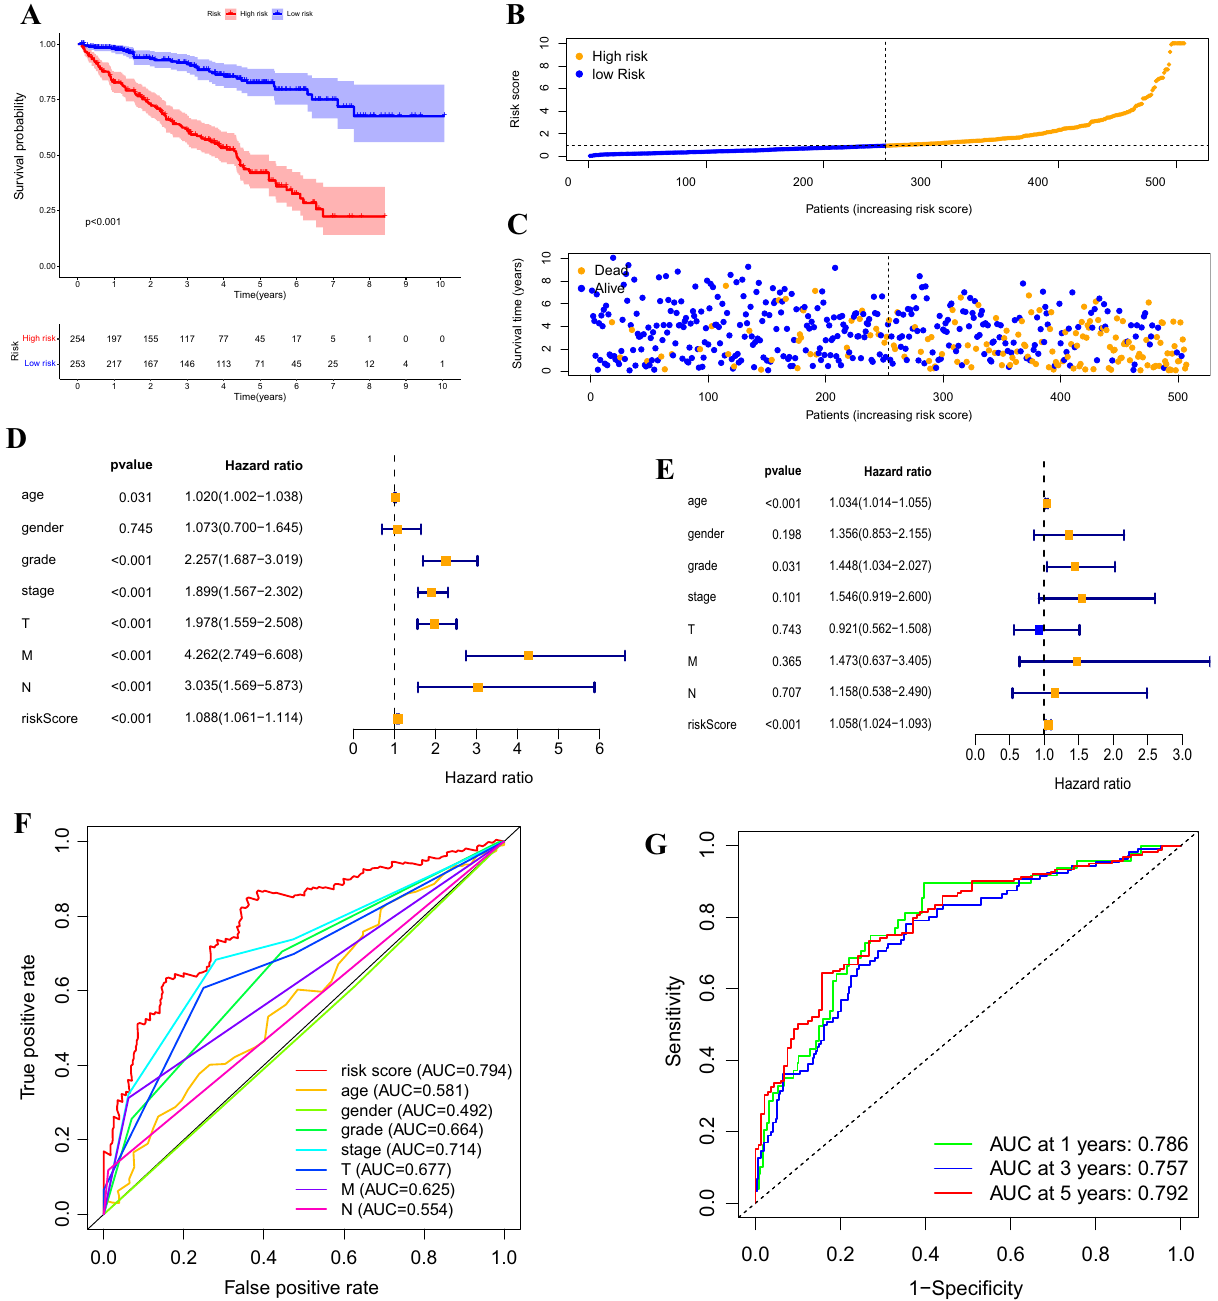
Figure 3. Correlation between the predictive signature and prognosis of patients with ccRCC. ( A ) Kaplan– Meier analysis of the overall survival rate of patients with ccRCC in the high-risk and low-risk groups. ( B ) The distribution of risk score among patients with ccRCC. ( C ) The number of dead and alive patients with different risk scores. Blue and yellow represents the numbers of survivors and deaths, respectively. ( D ) Forest plot for univariate Cox regression analysis. ( E ) Forest plot for multivariate Cox regression analysis. ( F ) The ROC curve of the risk score and clinicopathological variables. ( G ) ROC curve and AUCs at 1, 3, and 5 years survival for the predictive signature. ccRCC, clear cell renal cell carcinoma; ROC, receiver operating characteristic; AUC, area under the curve; T, tumour; N, lymph